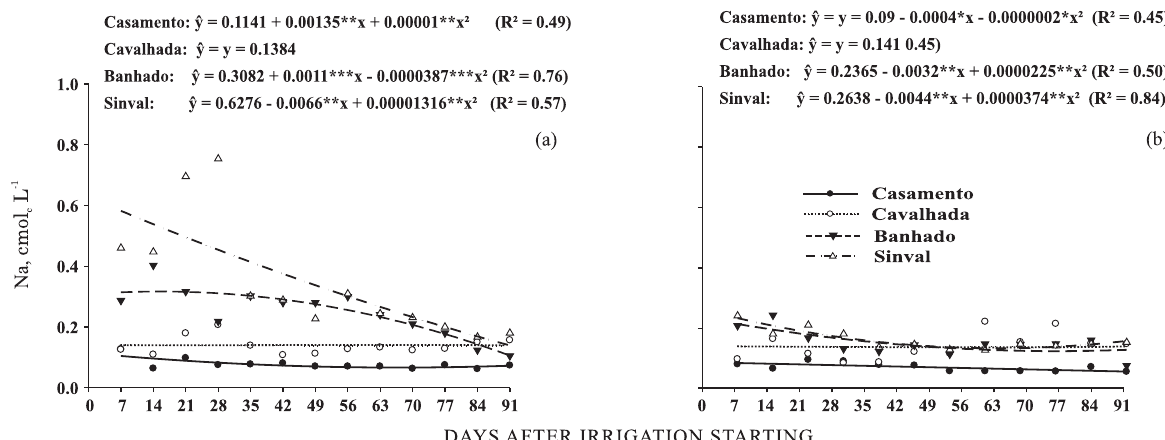
Figure 2. Sodium concentration in the water layer (a) and irrigation water (b), at the different sites. *, **, ***: significant at 10, 5 and 1 %, by the F-test,